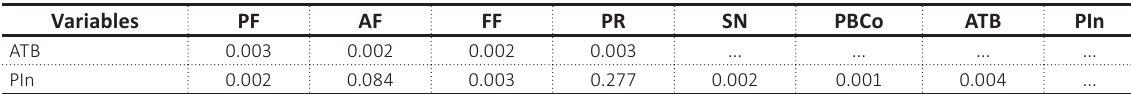
Table 7. Standardized direct effects: Two-tailed significance